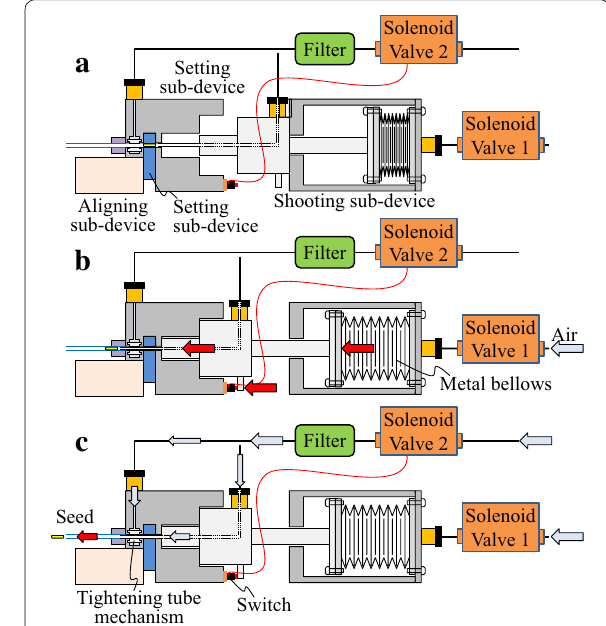
Fig. 13 a – c Show the motion procedure of the seed-shooting sub-